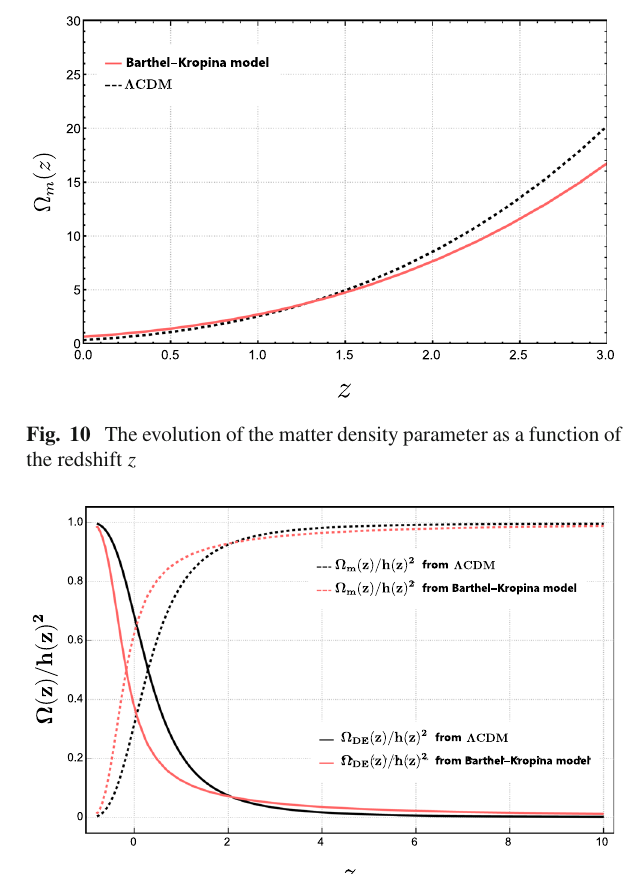
Kropina and (cid:2) CDM models. The evolution of the matter density parameters (cid:22) m are presented in Fig. 10. Up to red- shift of around z ≈ 2 the matter densities in the two mod- els almost coincide. However, at higher redshifts, significant differences begin to appear in the baryonic matter distribu- tions, with the Barthel–Kropina model predicting a higher value of the matter density parameter. The comparisons of the reduced matter and dark energy density parameters in the